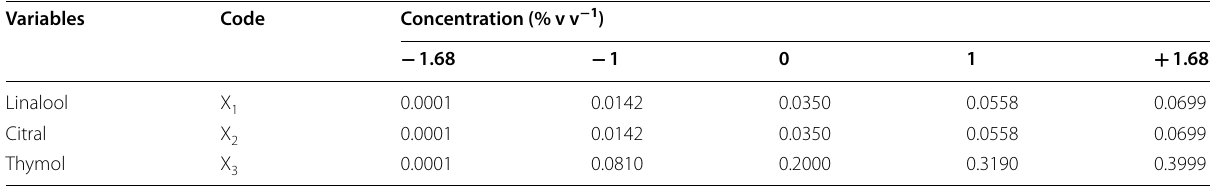
Table 3 CCRD matrix with coded and real values of the major components for determination of the minimum bactericidal concentration for S. flexneri biofilm growth